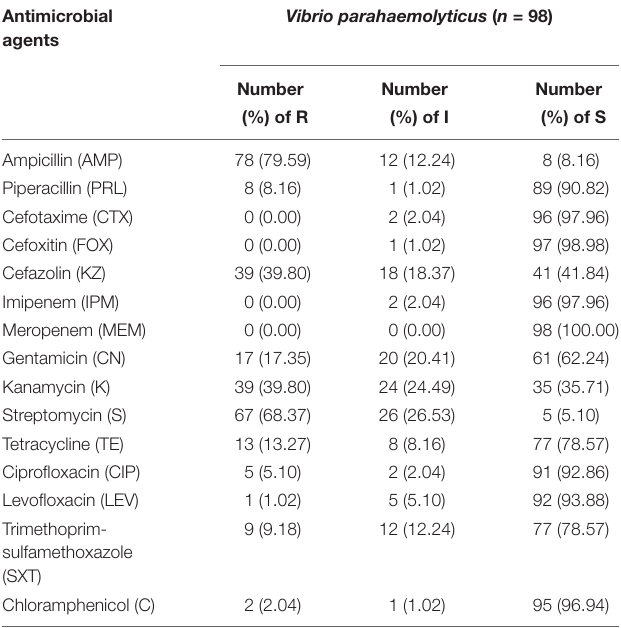
TABLE 3 | Antimicrobial resistance profiles of Vibrio parahaemolyticus isolates. Antimicrobial agents